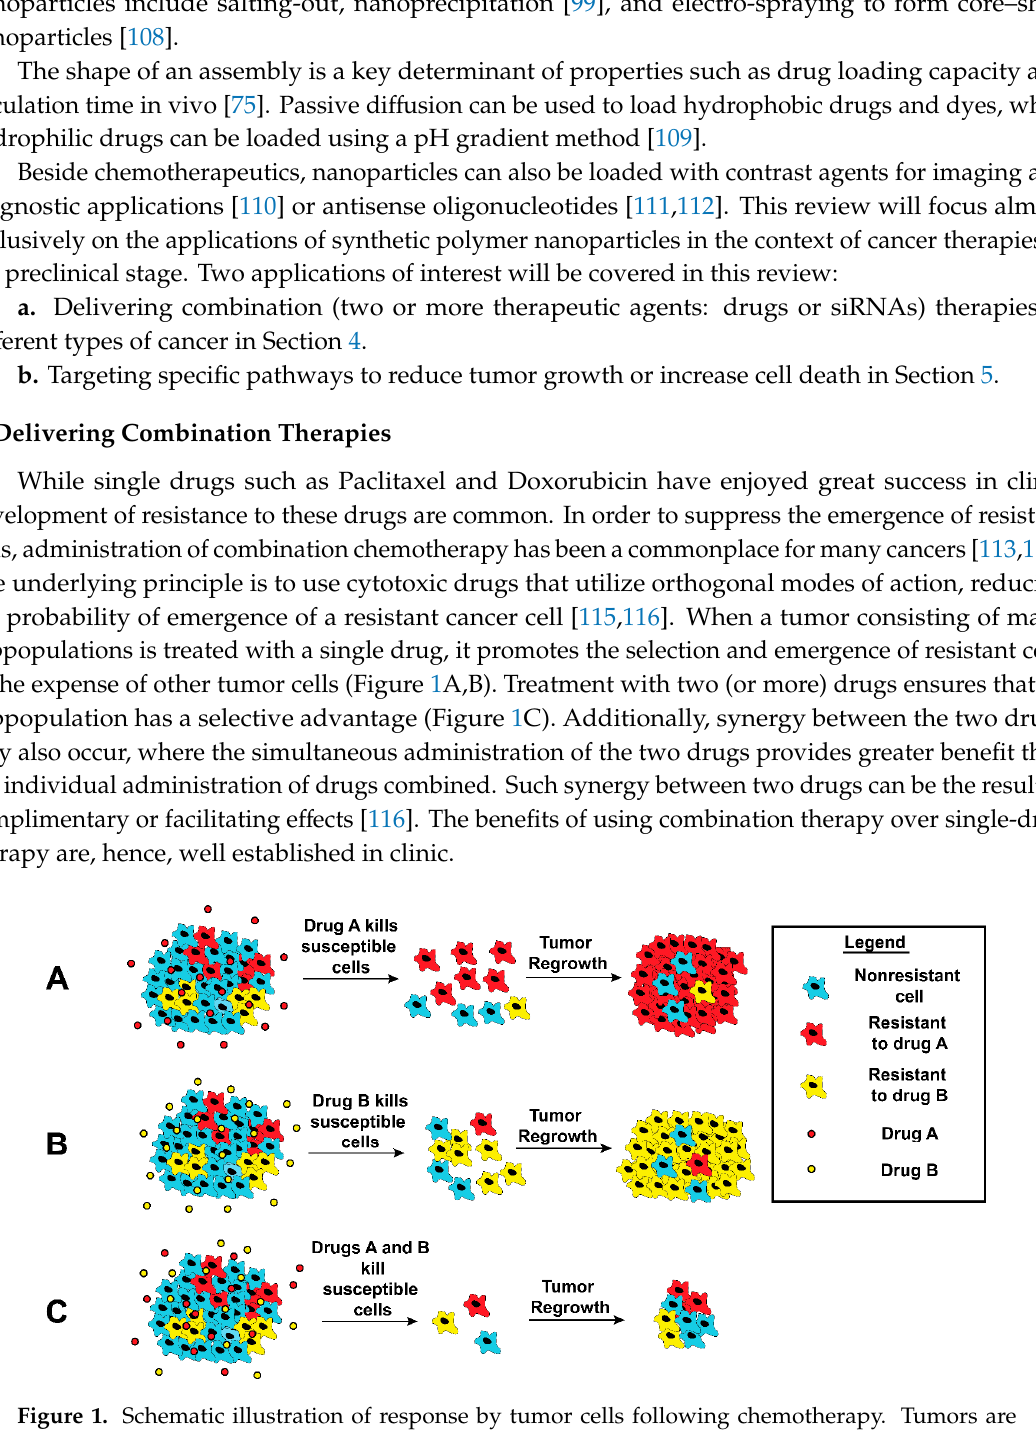
Figure 1. Schematic illustration of response by tumor cells following chemotherapy. Tumors are heterogeneous and consist of many subpopulations (here blue, red, and green) A and B. When cells are treated with a chemotherapeutic ( A or B ), the respective resistant subpopulations proliferate and eventually dominate. ( C ) Treatment with multiple drugs could eliminate this selectiveness and reduce the occurrence of resistance.